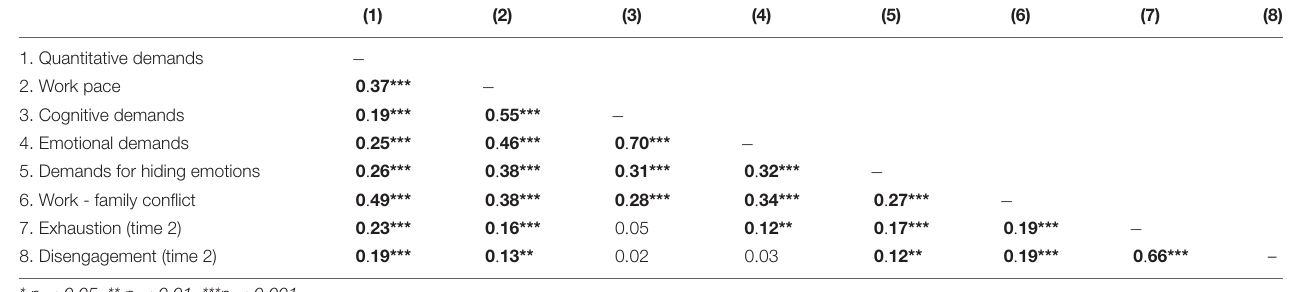
TABLE 1 | Pearson’s r correlational coefficients for main study constructs, N = 516.